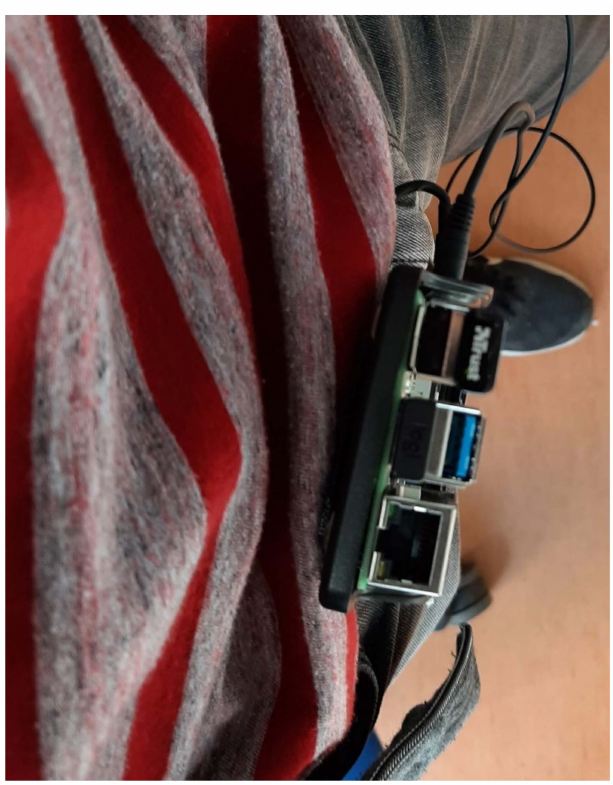
Figure 11. Raspberry Pi attached to a person’s